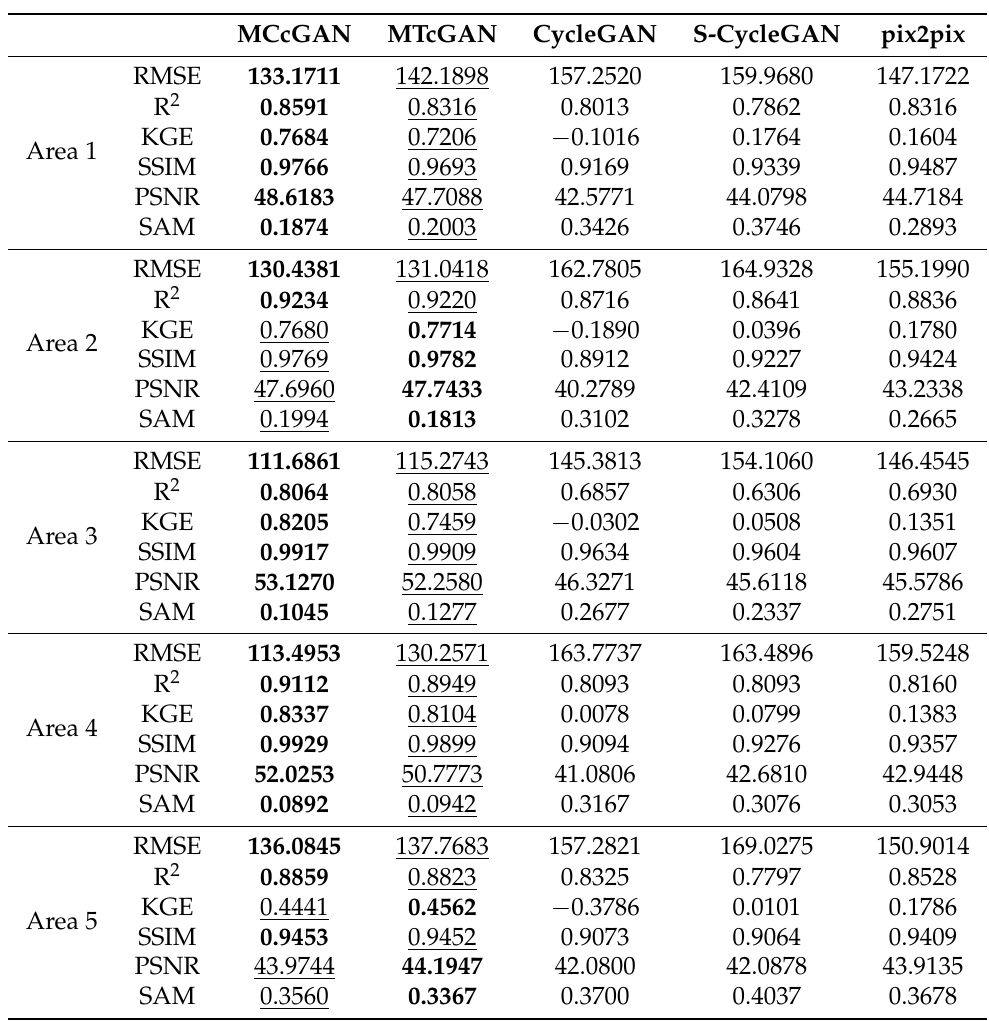
Table 8. The mean evaluation metrics of different methods for four bands in different areas (the bold result is the best among the different metrics, and the underlined result is the second